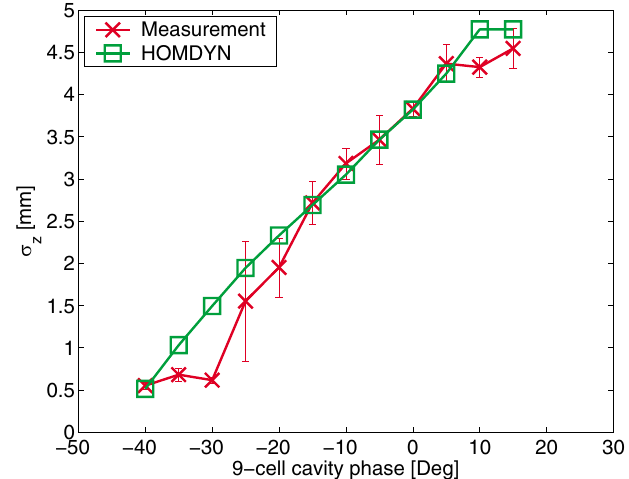
FIG. 5. (Color) Measured and simulated compression of an 8 nC beam as a function of the 9-cell cavity phase. The (cid:6) corresponds to acceleration on